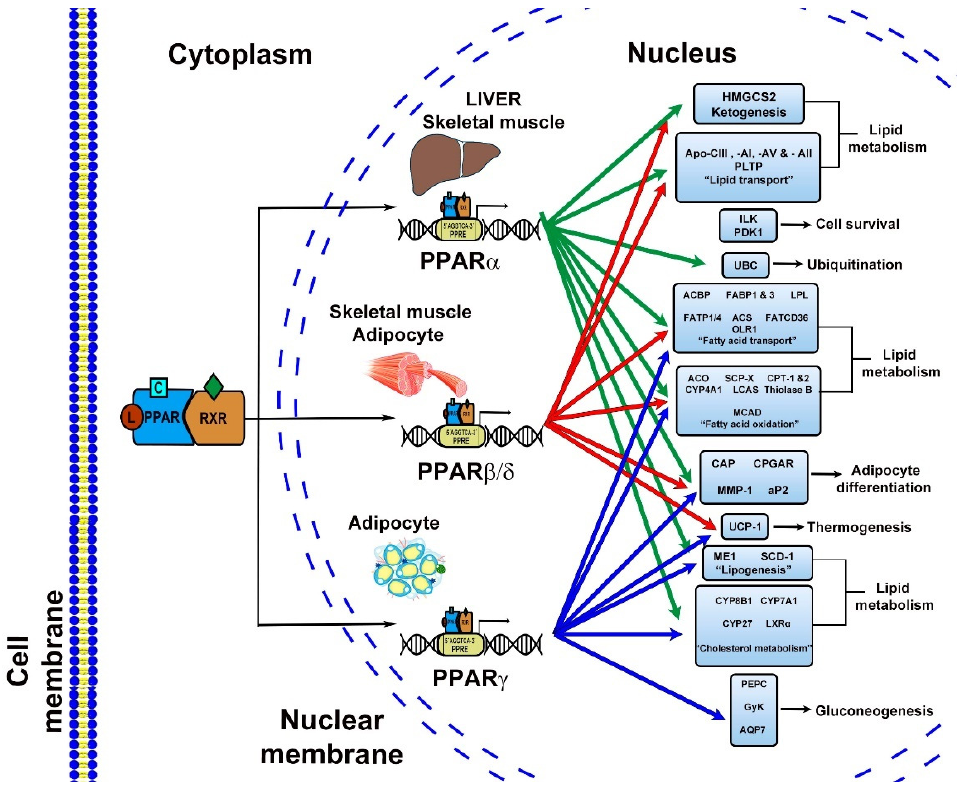
Figure 2. PPARs’ signal transduction. The signal pathways where PPARs are involved affects gluconeogenesis, lipid metabolism, thermogenesis, adipocyte differentiation, ubiquitination and cell survival, depending on the target gene and tissues where they are activated.